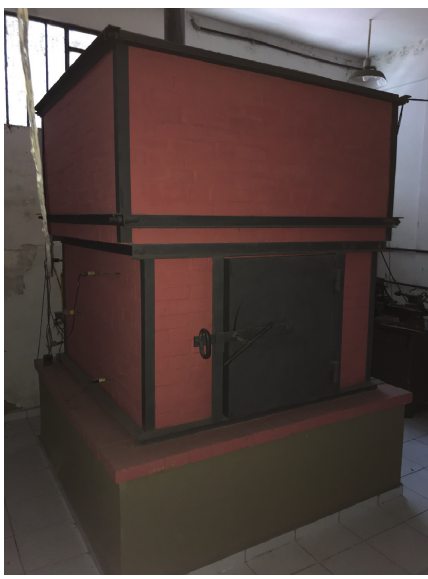
Figure 2: Intermittent ceramic kiln under analysis.